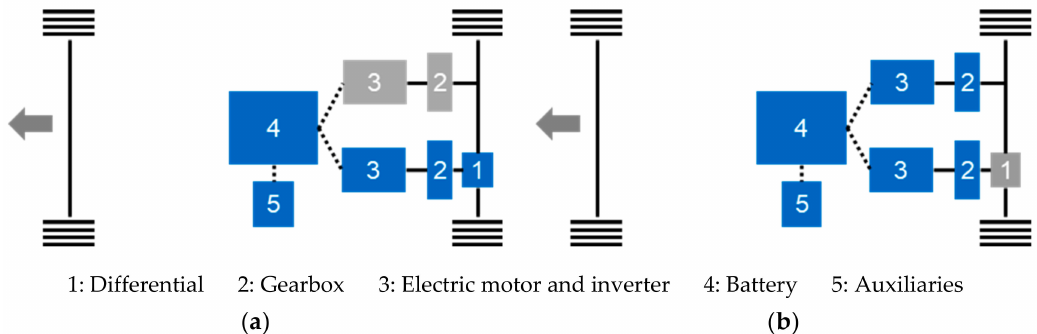
Figure 6. Powertrain Architectures of single motor rear wheel drive ( a ) and ( b ) dual wheel-hub